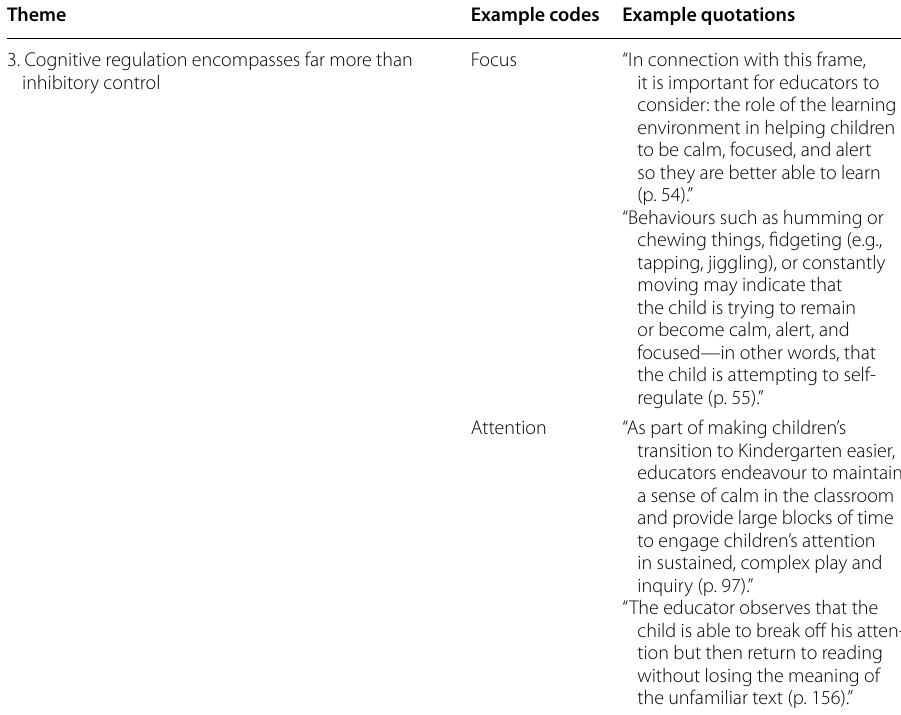
Table 4 Overview of Theme 3, example codes, and quotations